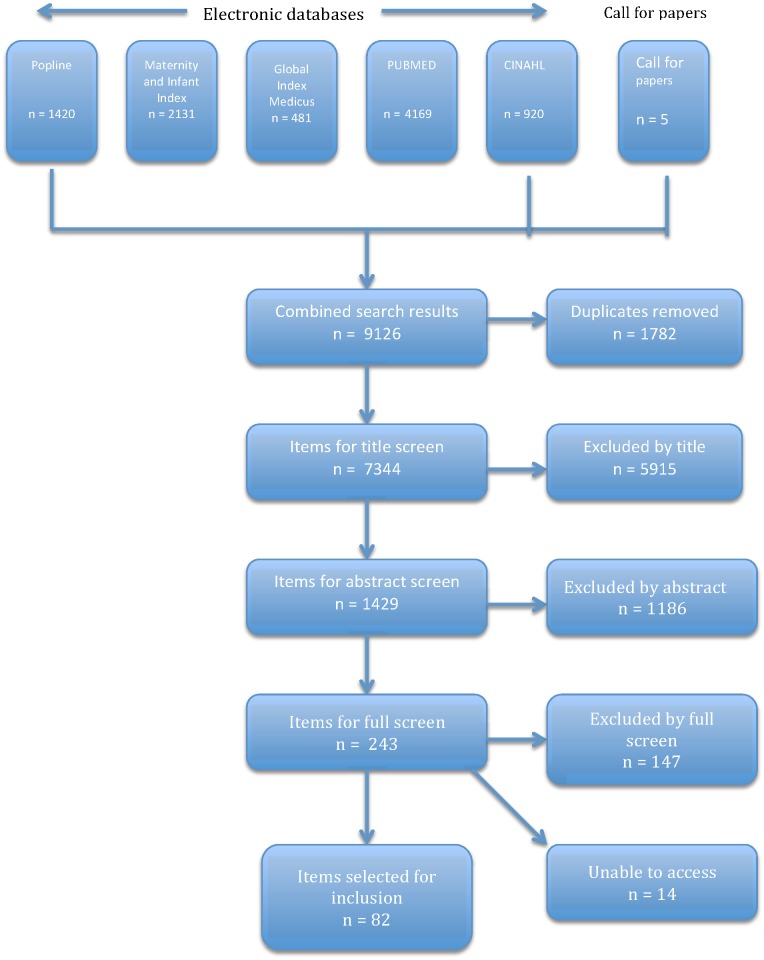
Mapping results.